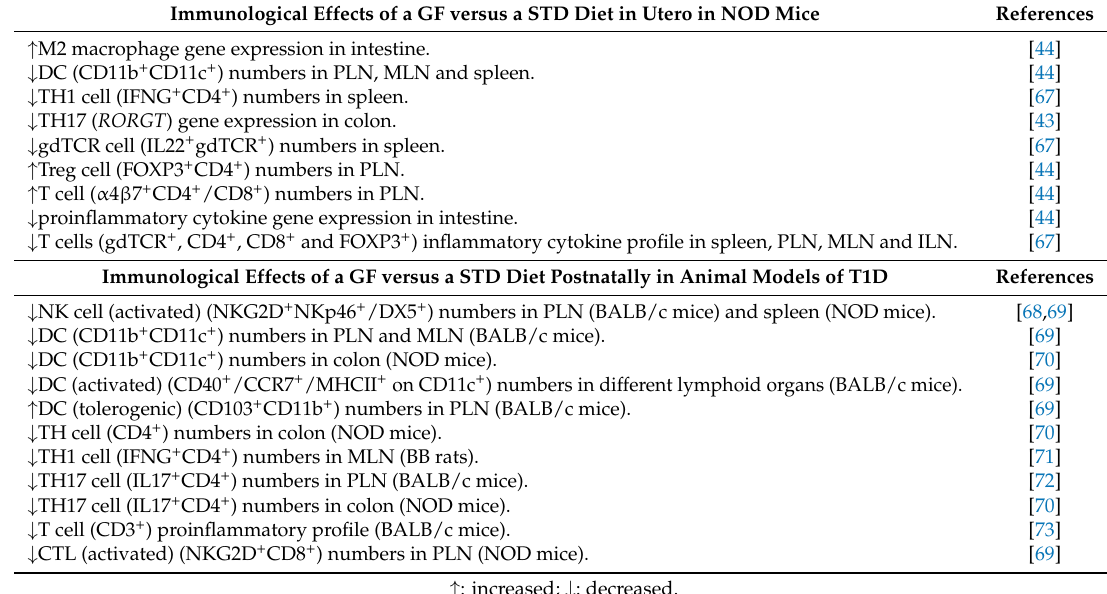
Table 1. An overview of some of the effects that a gluten-free (GF) diet has on the immune system in animal models of type 1 diabetes